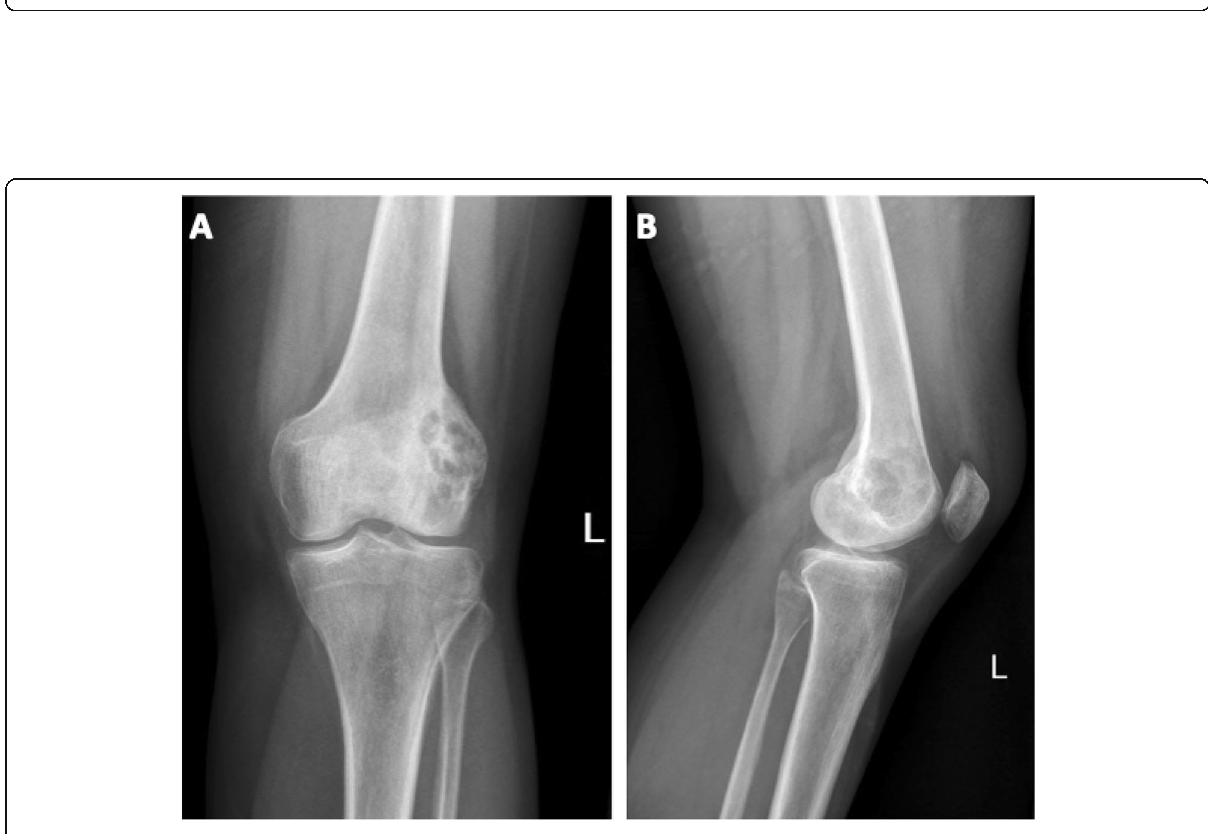
Fig. 3 a Photomicrograph demonstrating hypercellularity (× 10, H&E) b Photomicrograph demonstrating rhabdomyoblasts with pleomorphic nuclei (× 40, H&E) c Immunohistochemical staining positive for desmin, indicative of muscle differentiation